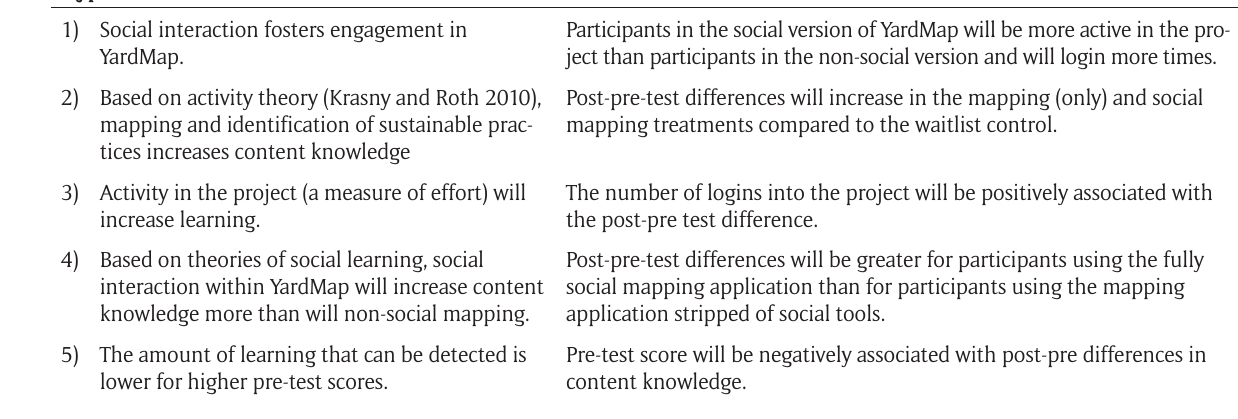
Table 1: A priori hypotheses and predictions driving experimental treatments or inclusion of additional explanatory and control